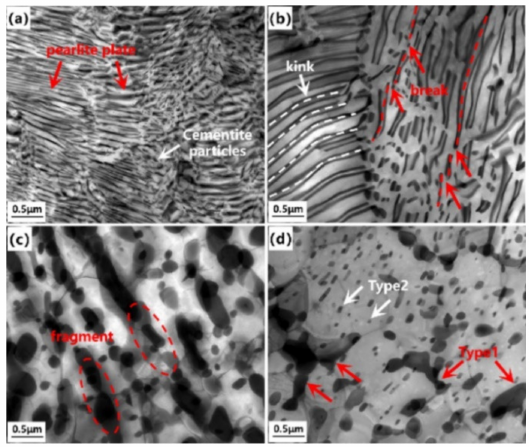
Figure 3. TEM microstructures at different deformation strains: ( a ) 20%, ( b ) 40%, ( c ) 60%, ( d ) 75%.